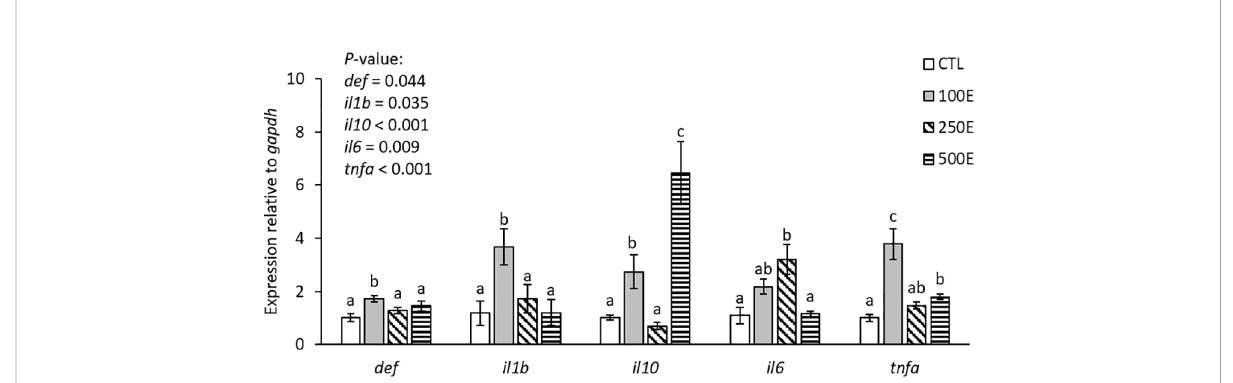
FIGURE 5 Intestinal gene expressions (mean ± SE) of rainbow trout fed diets supplemented with 0-500 mg/kg HE over eight weeks. Different letters above the bars indicate signi fi cant differences among the treatments (Duncan test; n =